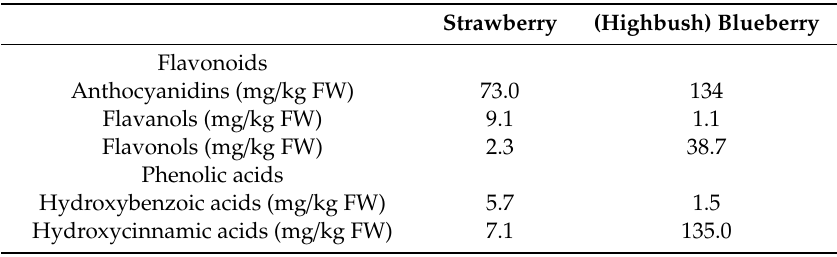
Table 1. Chemical composition of strawberry and blueberry